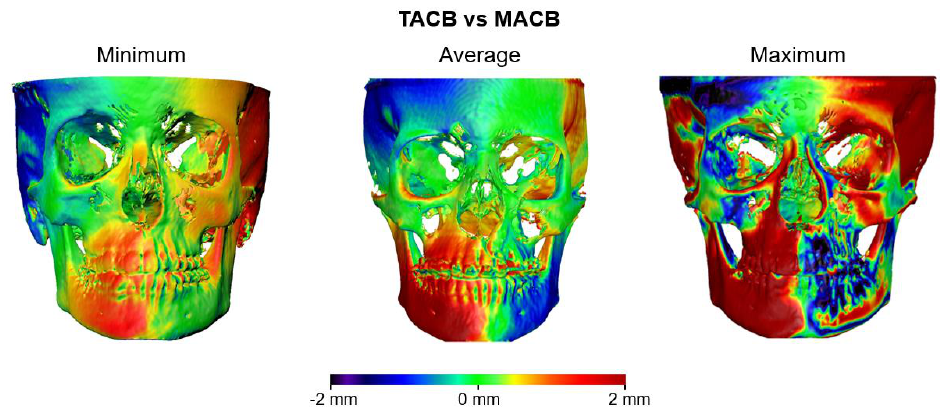
Figure 5. Bland–Altman plots of the T0–T1 changes (mm) detected through the TACB and the MACB superimpositions by the same operator. The continuous horizontal line shows the mean of the differences in the detected T0–T1 changes, and the dashed lines show the corresponding 95% Limits of Agreement. TACB: Total Anterior Cranial Base; MACB: Middle Anterior Cranial Base.